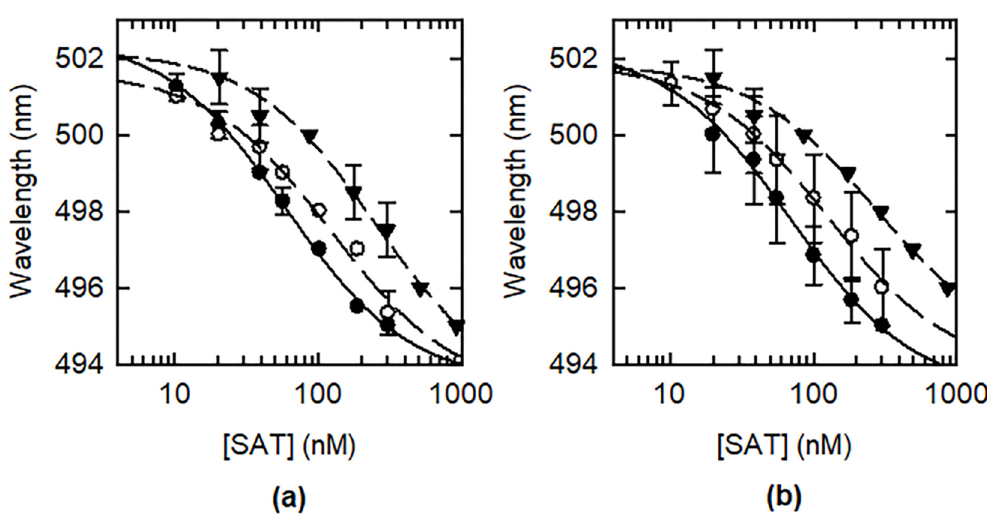
Figure 6. StCS ( a ) and EcCS ( b ) complex formation in the presence of 2 µM (closed circles), 5 µM (open circles) or 10 µM (closed triangles) UPAR415. The displacement of UPAR415 by SAT from OASS-A active site is followed as wavelength shift as a function of SAT concentration. Data were fitted to a binding isotherm, giving the apparent K D values reported in Table 1. Data represent the mean of technical triplicates and their standard deviations.